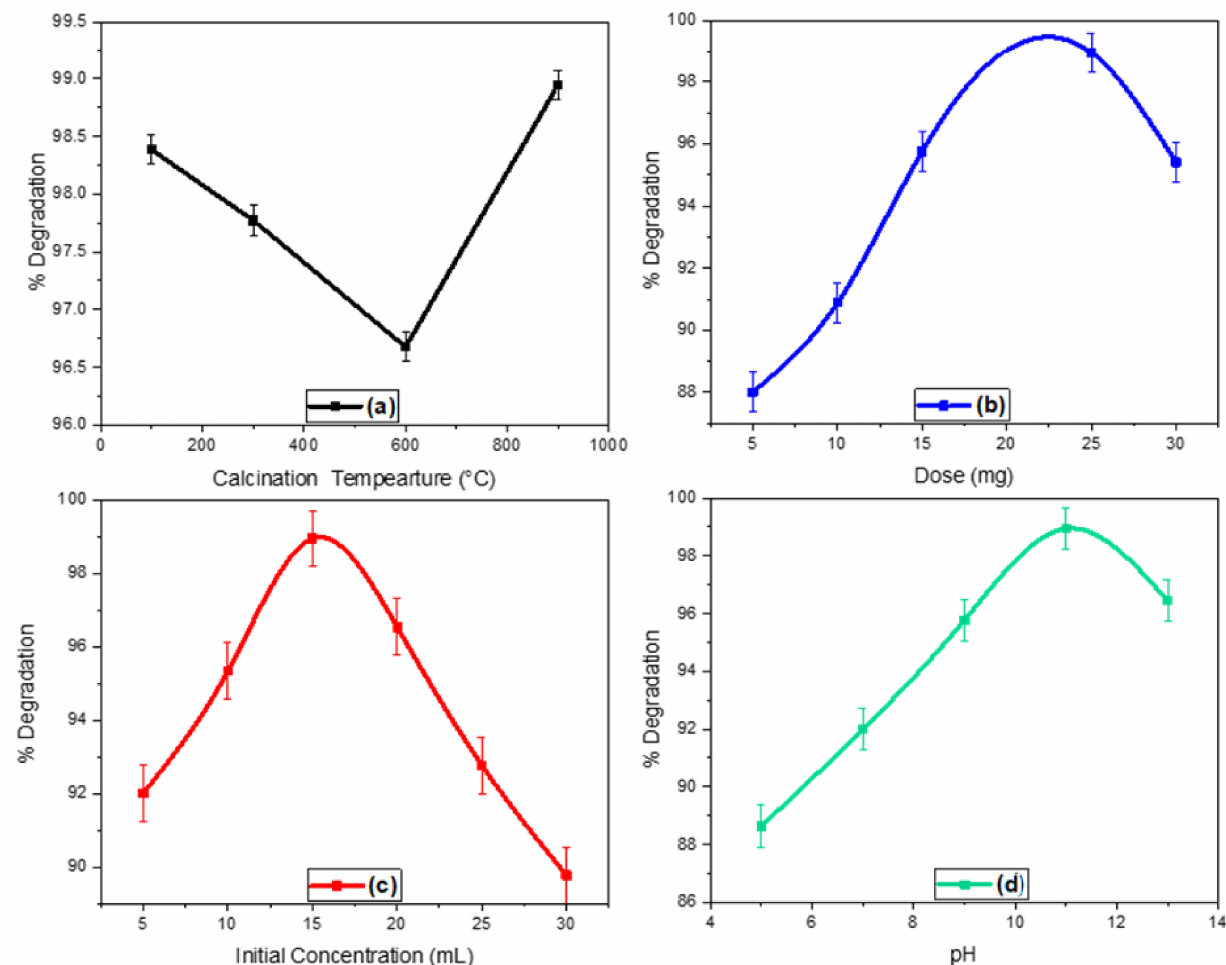
Figure 7. The factors effecting photocatalytic degradation of rhodamine 6G; ( a ) effect of temperature, ( b ) effect of catalyst dose, ( c ) effect of initial concentration, and ( d ) effect of